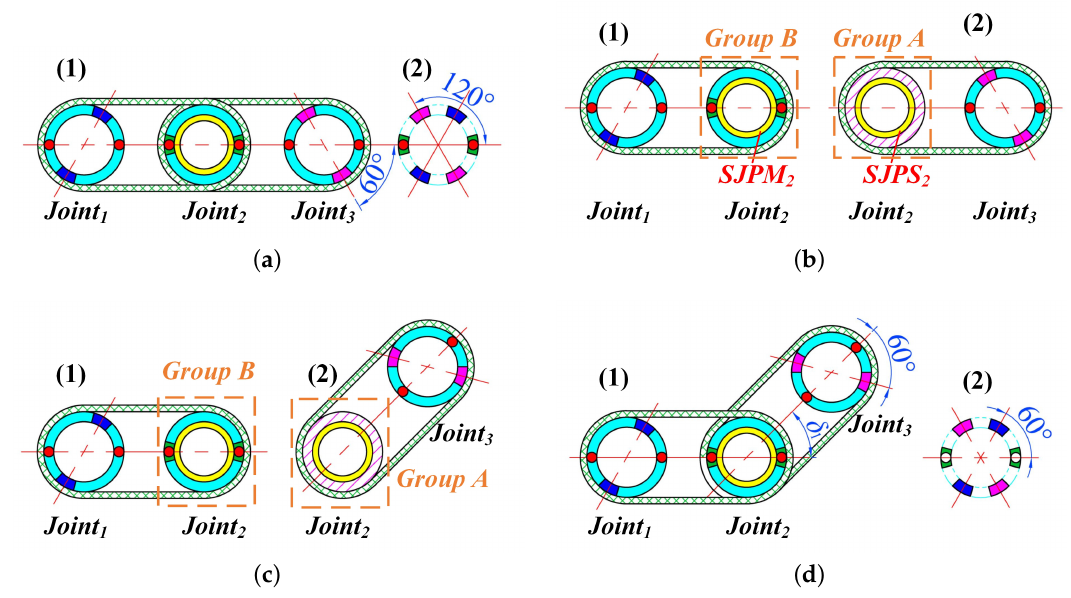
Figure 16. There is no phase difference for the P 3 after the Joint 2 rotates δ 1 by the two clutches that are used for separating the power transmission of cams’ rotation when the joint is driven. The structures of GroupA , GroupB , SJPM 2 and SJPS 2 are shown in Figure 1. ( a ) The iniational status of three joints. ( b ) The Joint 2 is divided into Group A and Group B. ( c ) The Joint 2 rotates δ 1 . ( d ) The Joint 2 recover to the original